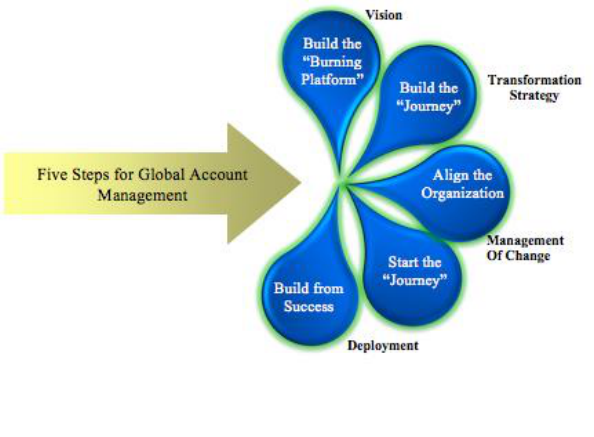
Figure 1 : Implementation Path for a Global Account Management